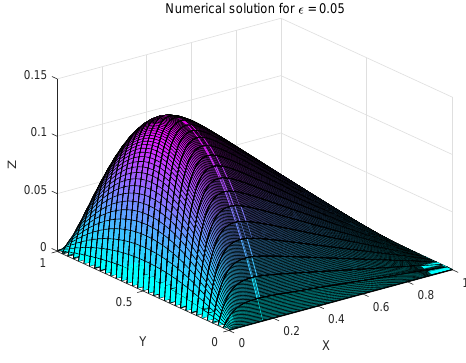
Figure 2. Example